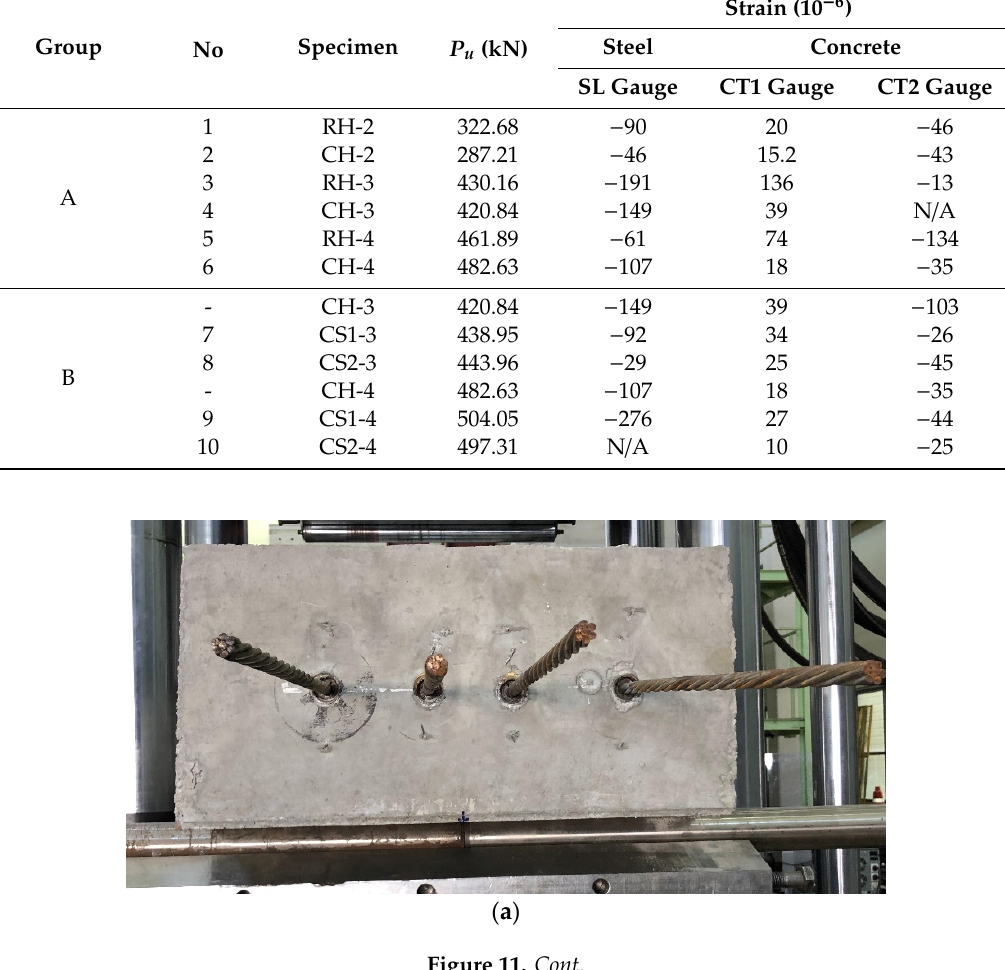
Table 4. Strain of reinforcement steel and concrete in the anchorage zone.